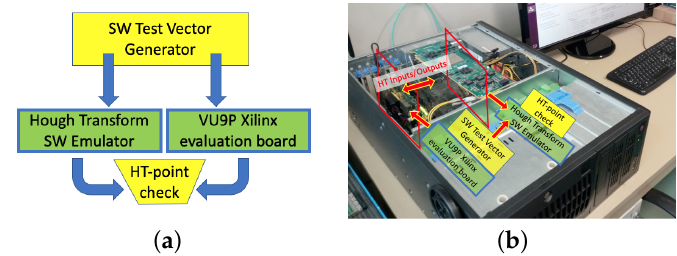
Figure 4. Test Stand demonstrator: ( a ) HT SW tool, ( b ) HT FW implementation.